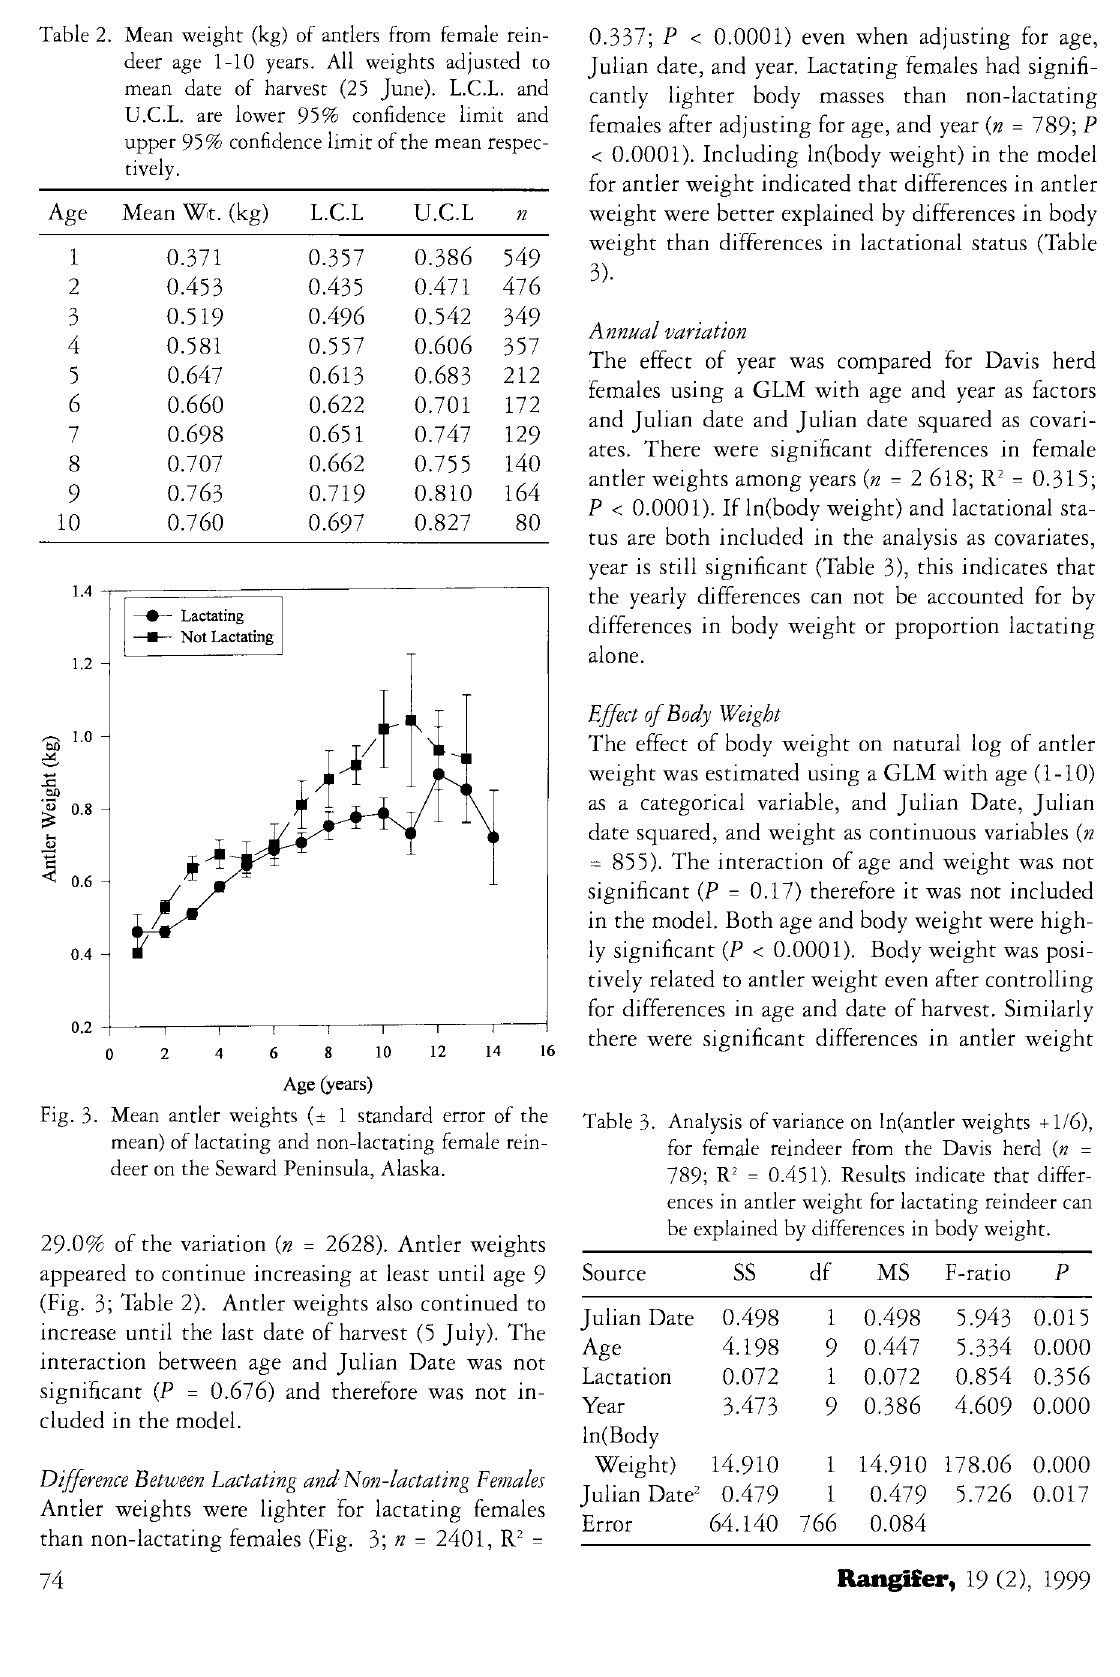
Table 2. Mean weight (kg) of antlers from female rein deer age 1-10 years. All weights adjusted to mean date of harvesr (25 June). L.C.L. and U.C.L. are lower 95% confidence limit and upper 95% confidence limit of the mean respec tively.